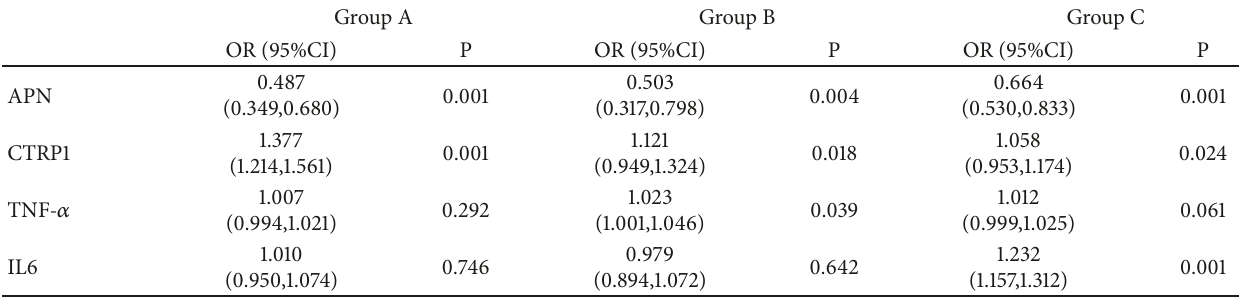
Table 5: Multiple logistic regression analysis in subgroups.